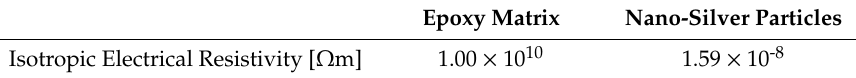
Table 1. Electrical properties of the polymer matrix and filler particles [10].